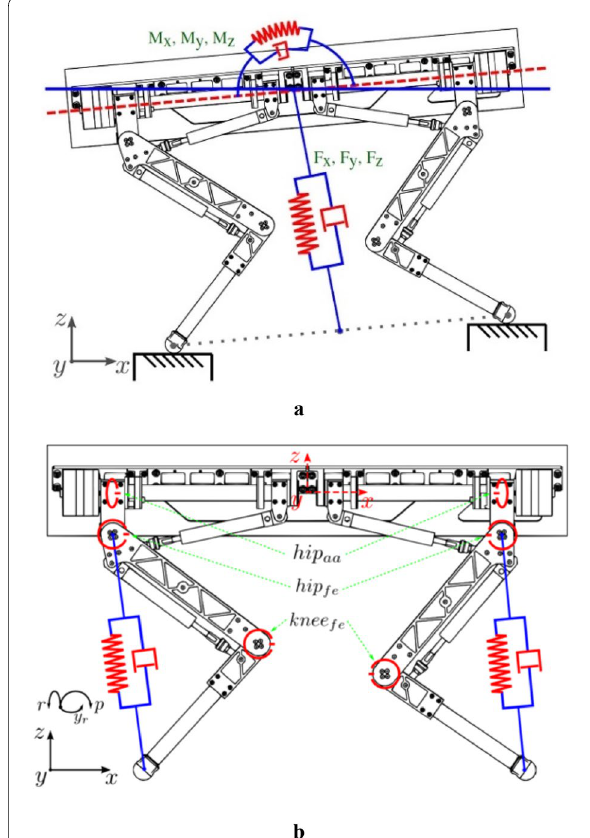
Figure 18 Modeling of HyQ robot based on VMC: a Virtual component of torso [99]; b Virtual components of leg